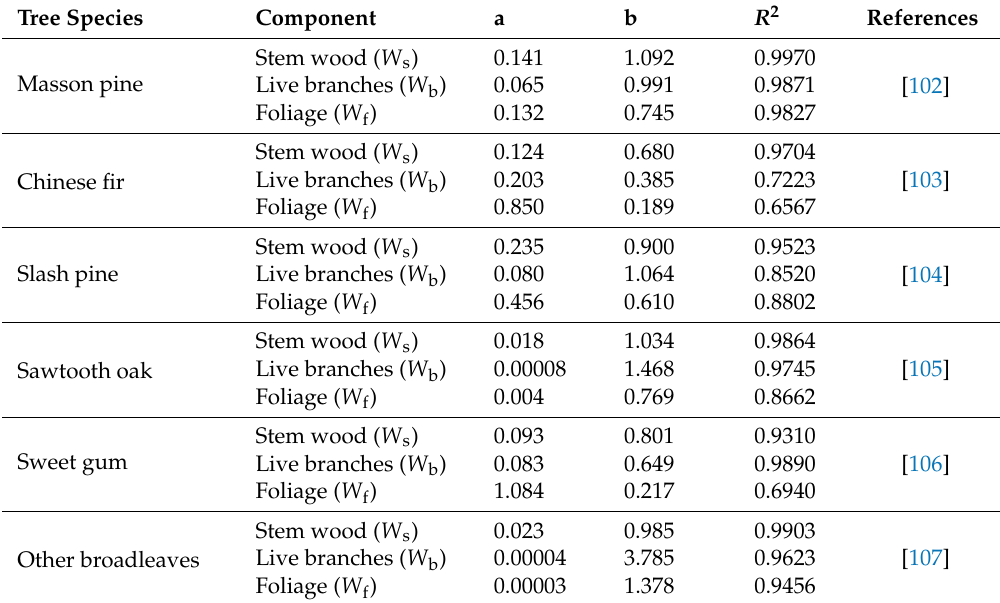
Table A1. Allometric equations used in this study for aboveground biomass